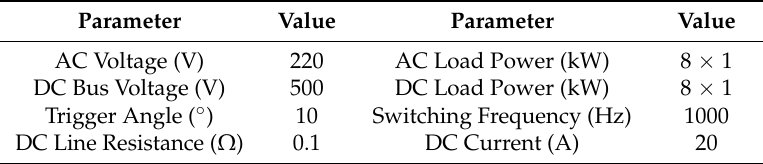
Table 5. Parameter of the single-ended radial DC distribution network.